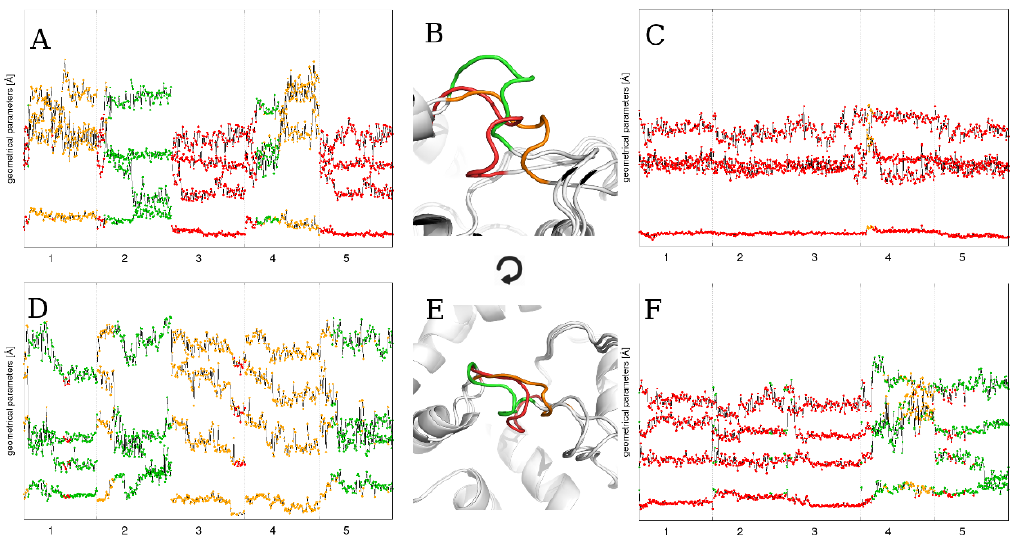
Figure 5. The time evolution of the four statistically significant loop parameters during five 100 ns MD runs using particular flexible loop models as a starting point: ( A ) FL_m1, ( C ) FL_m2, ( D ) FL_m3, and ( F ) FL_mDOPE, and ( B ) averaged loop structures in identified conformations: “open” (green), “semi-open” (orange), and “closed” (red), and ( E ) top view. The numbers on the horizontal axes represent the simulation repetition. Please note the colored points representing each loop conformational state and how the loop changes its conformation depending on the loop model used as a starting point.